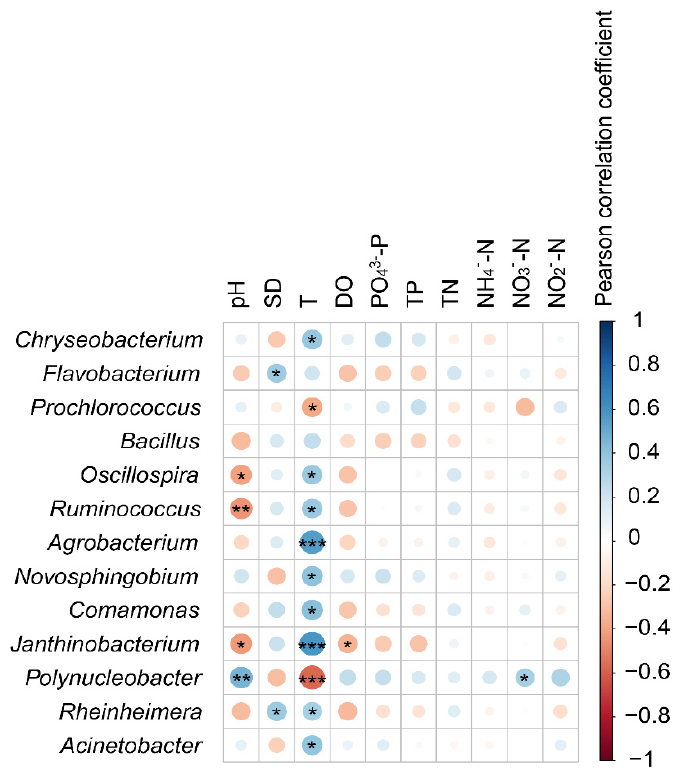
Figure 6. Pearson correlation coefficient between the dominant genus and environmental variables. * p < 0.05, ** p < 0.01, *** p < 0.001.